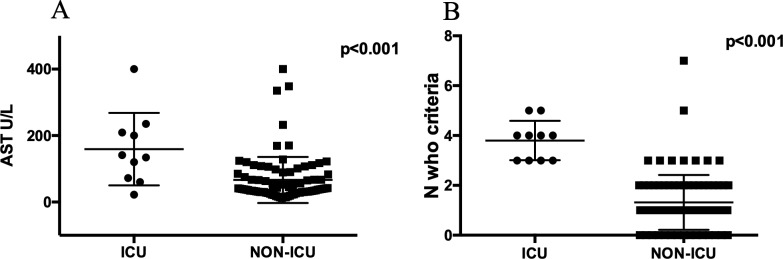
Aspartate aminotransferase levels (A) and N_WHO criteria (B) between ICU and non-ICU patients. Intensive Care Unit (ICU) group showed a significantly higher aspartate aminotransferase (AST) value (A) and higher number of WHO criteria (B) compared to non-ICU group.